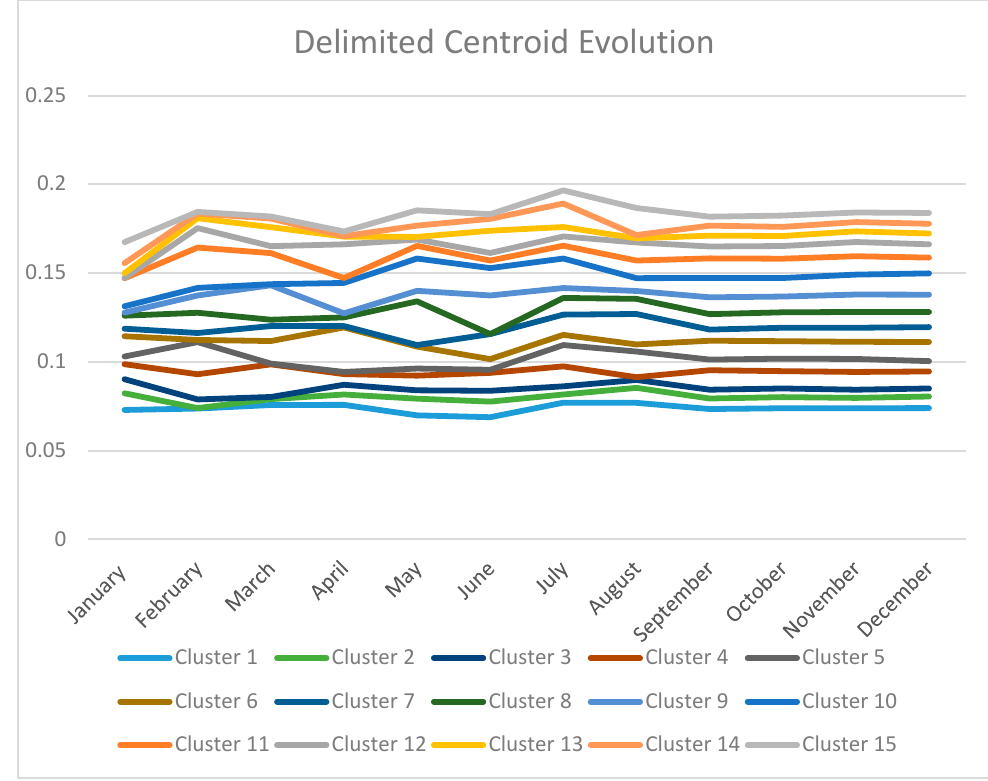
Figure 3. Bounded clustering with X-Means (K max = 15).